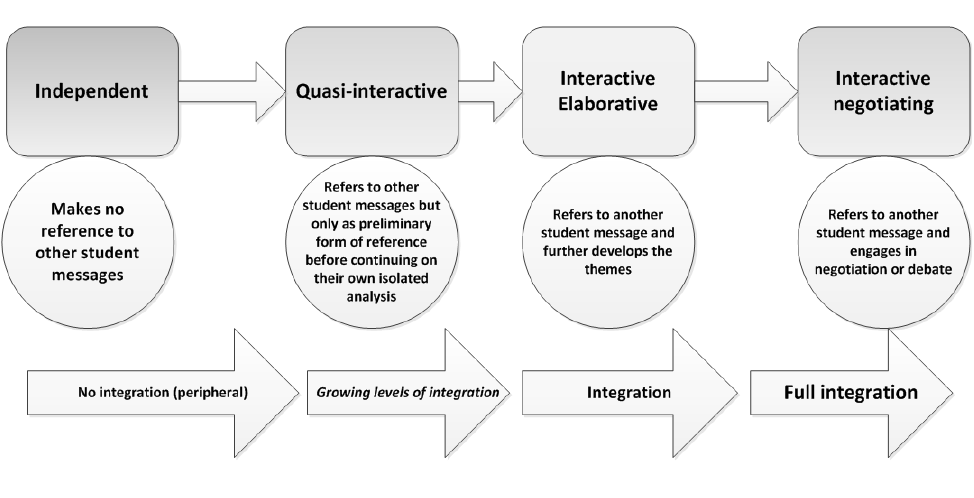
Figure 1 . Henri’s taxonomy of interaction